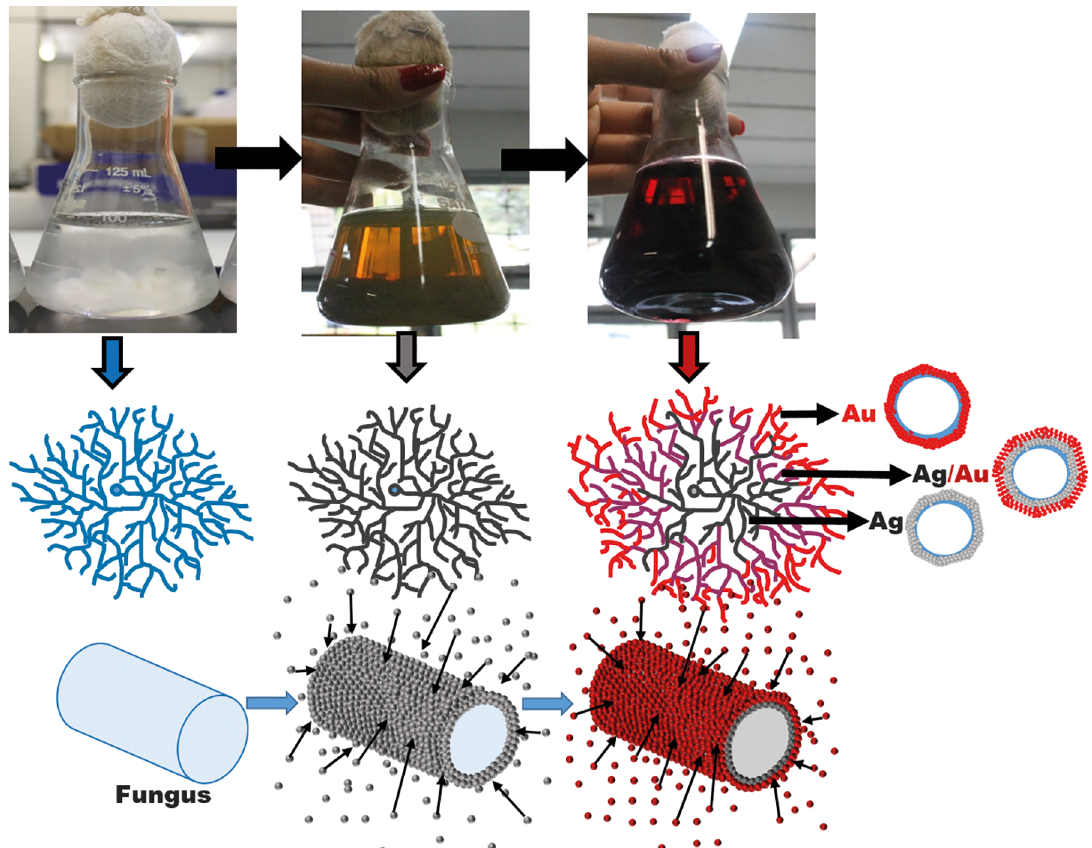
Figure 5. Ilustrative scheme of the different composition regions of the hyphae. Center of the hyphae is composed by AgNP. In an intermediated region, AgNP and AuNP. In the tips, AuNP